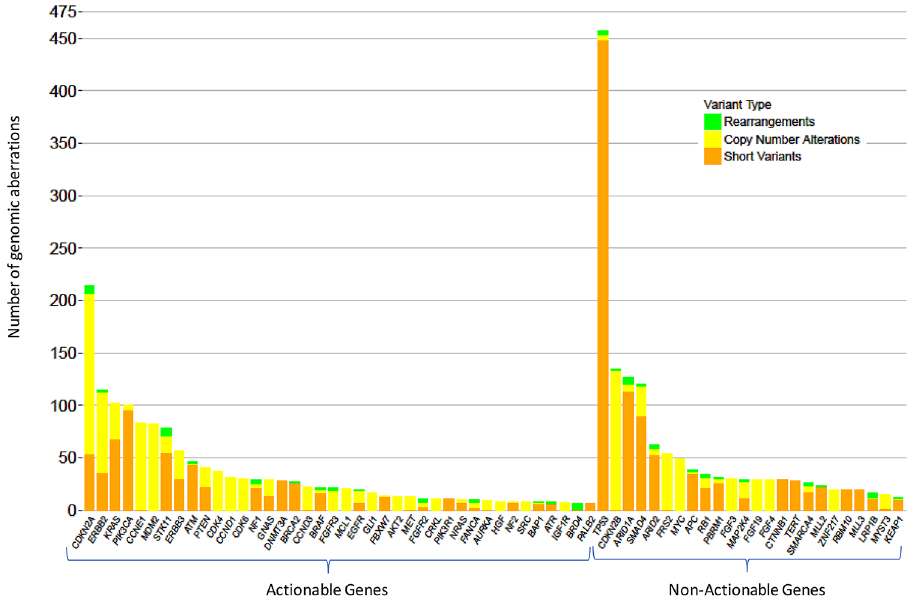
Figure 1. Most common genomic aberrations in 760 patients with gallbladder